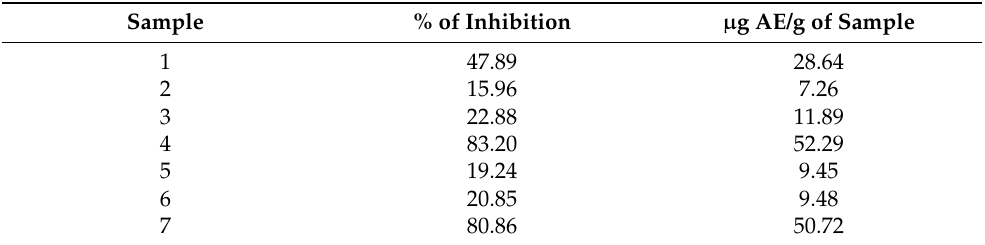
Table 4. Results expressed as percentage of inhibition and in µ g AE/g of sample (DPPH method).